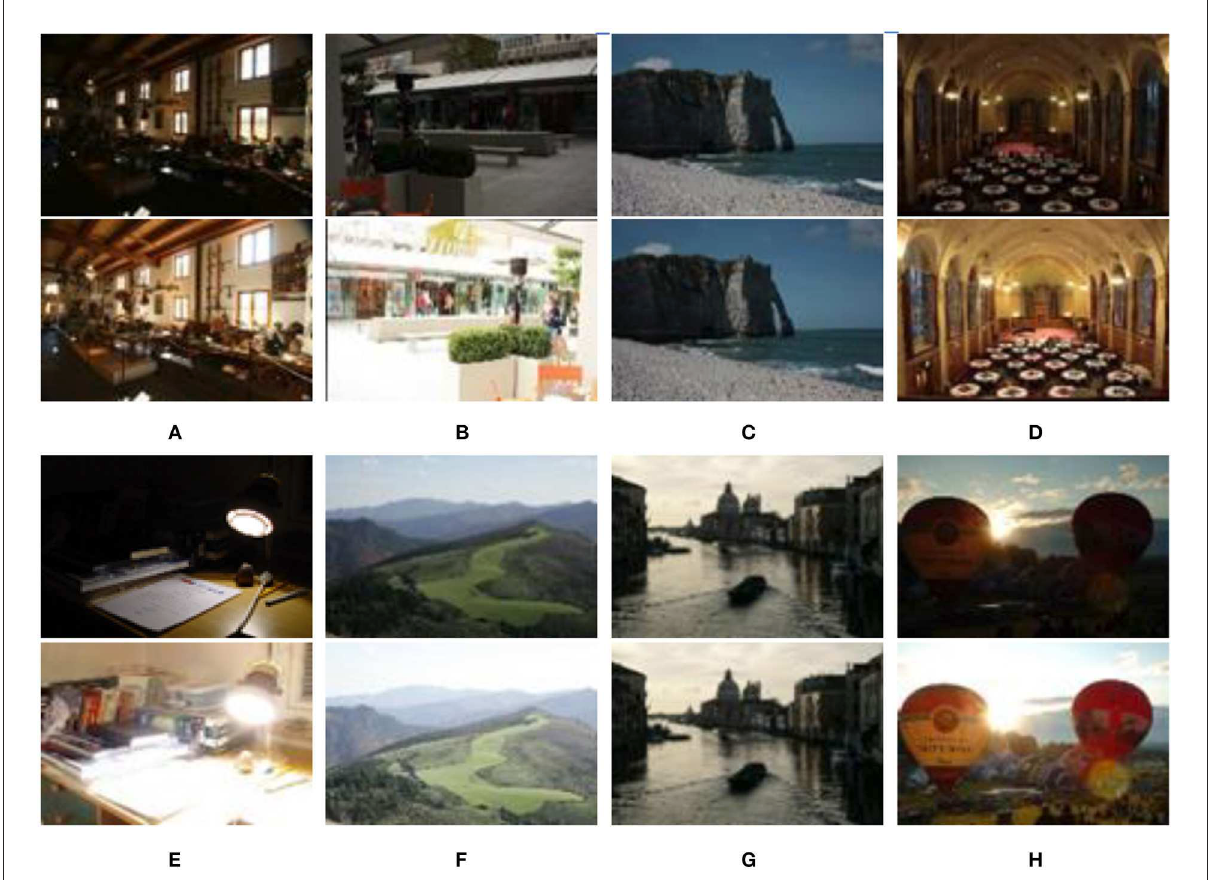
FIGURE6 Source image sequences used in experiments. (A) Farmhouse; (B) Brunswick; (C) Cliff; (D) Llandudno; (E) Cadik; (F) Landscape; (G) Venice; (H)